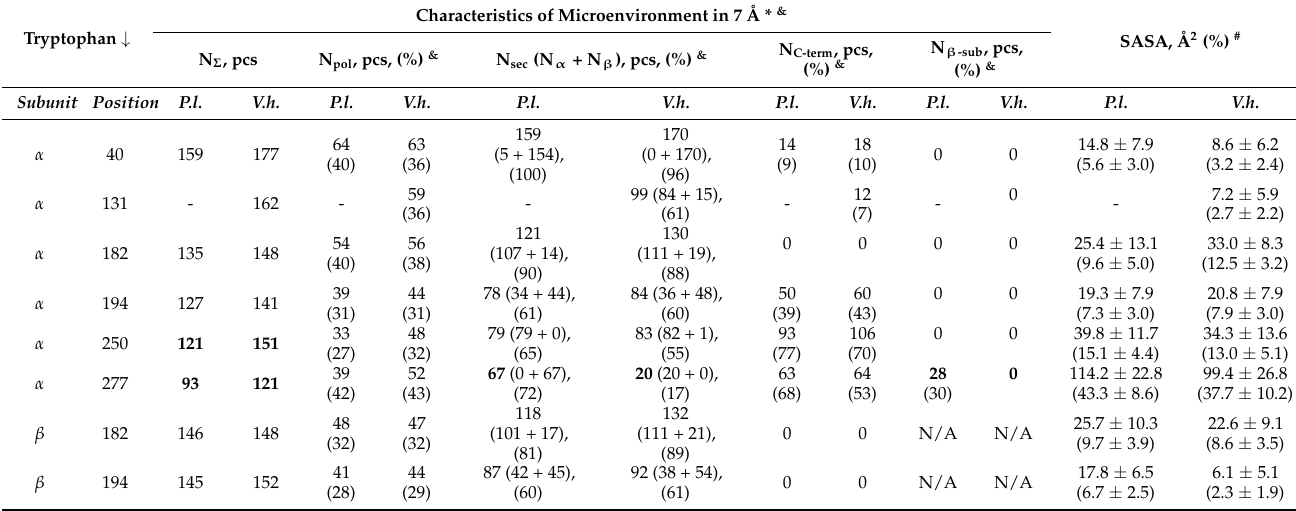
SASA, Å 2 (%) # N β -sub , pcs, (%) &